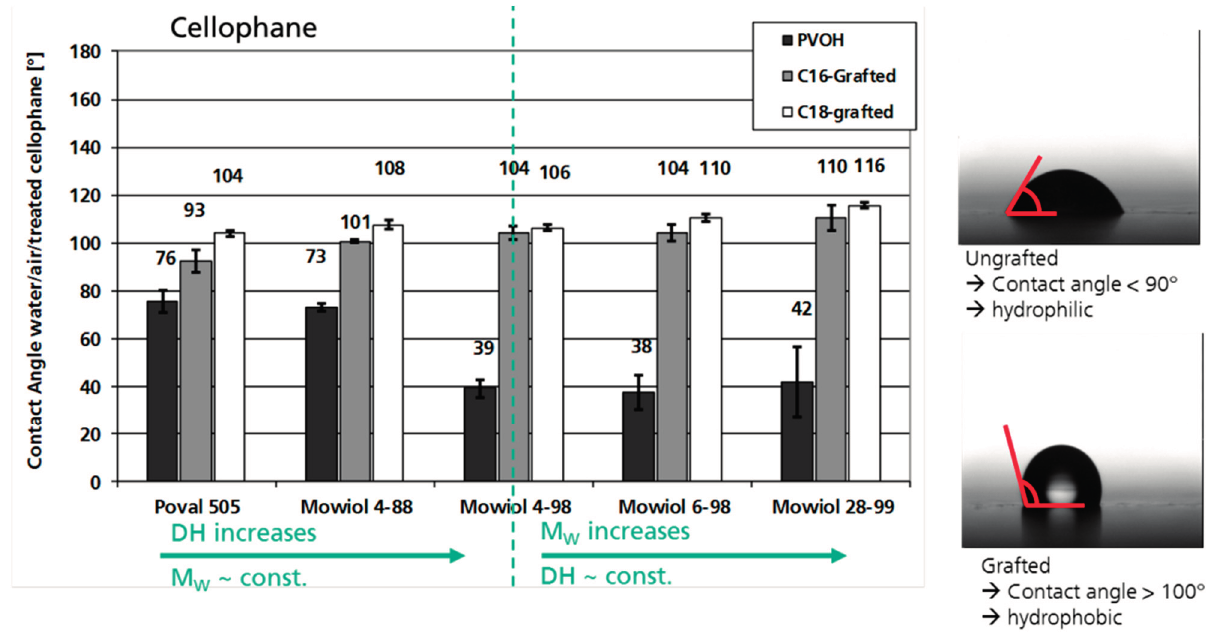
Figure 4. Contact angle with water on different PVOH grades before/after C16 and C18 grafting, substrate: cellophane (CEL). DH, degree of